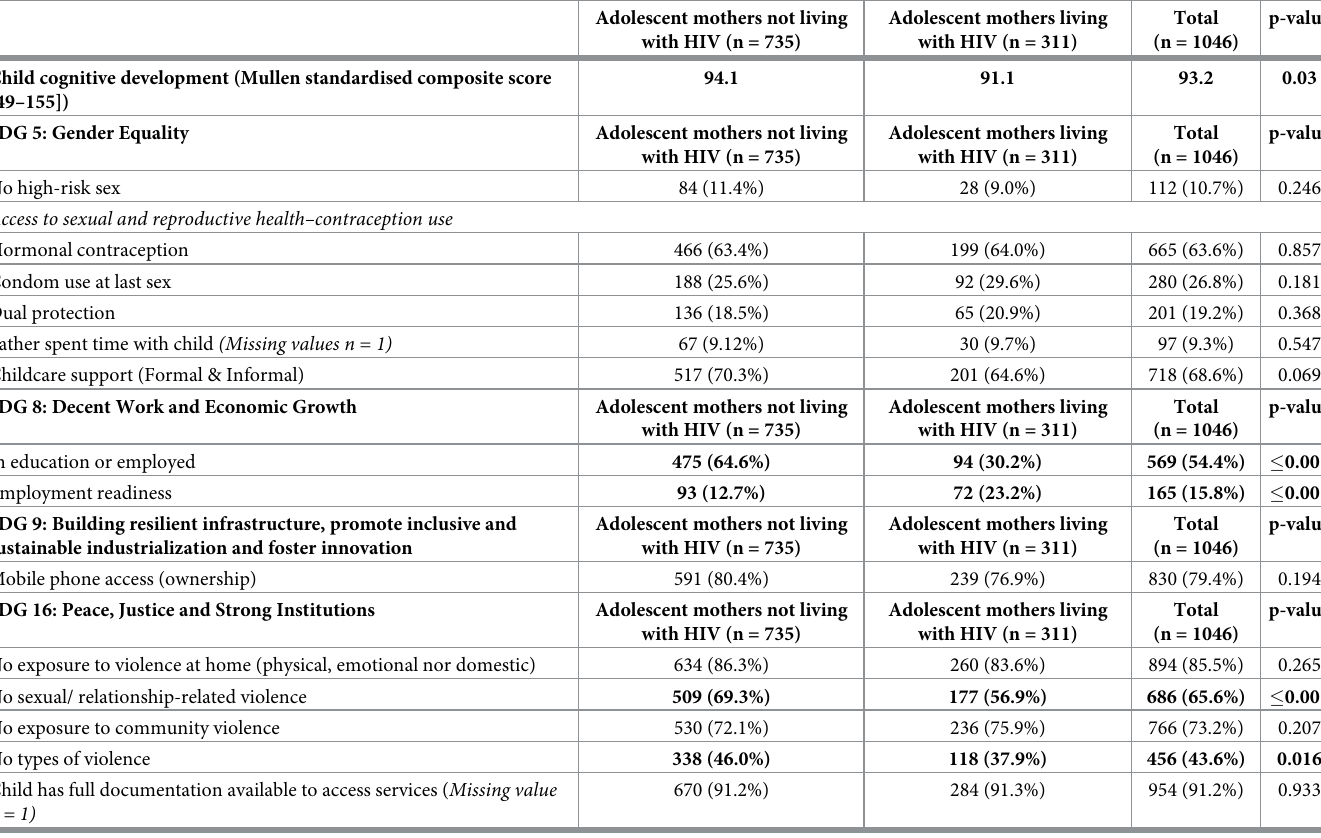
Goal 4 –Quality education. Although nine in ten (89.3%) adolescent girls and young women were enrolled in school before they became pregnant, only three-quarters (74.1%) attended school during pregnancy and under two-thirds (68.0%) returned to school after giving birth to their child. Adolescent mothers living with HIV were less likely to report positive education outcomes: they were less likely to have been in school before they became pregnant (76.6% vs 94.5%, p < 0.001), less likely to attend school during pregnancy (62.3% vs 78.0%, p < 0.001), and less likely to return to school after giving birth (51.2% vs 74.65, p < 0.001). Two-thirds of adolescent mothers reported delayed grade progression, and ado- lescent mothers living with HIV were more likely to report educational delays (22.2% vs 39.3%, p < 0.001). More than one-quarter (28.0%) of the children of adolescent mothers attended early childhood development services, with no difference by maternal HIV status. Children of adolescent mothers living with HIV were more likely to score lower on the Mul- len Scales of Early Learning compared to children of mothers not living with HIV (91.1 vs 94.1, p < 0.03). Goal 5 –Gender equality. Nine out of ten adolescent mothers engaged in high-risk sex, with no difference by HIV status. Nearly two thirds of adolescent mothers reported hormonal contraception use, but just over one-quarter reported condom use at last sex, with no differ- ence by HIV status. Only a tenth of fathers spent time with their children, and seven in ten adolescent mothers received childcare support. Both did not differ by HIV